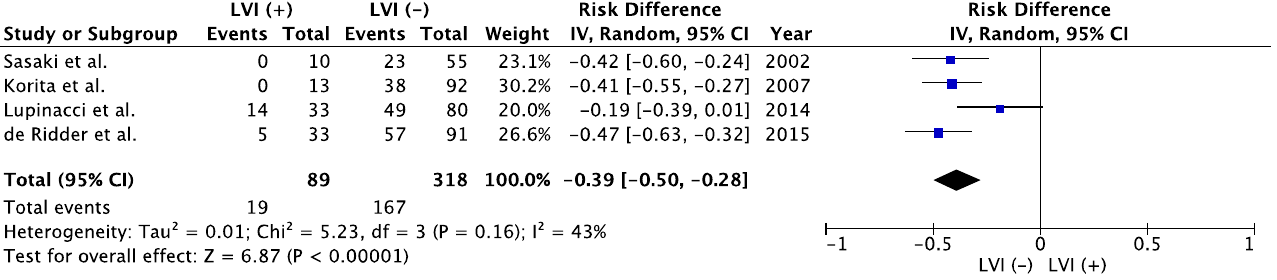
Figure 3. Meta-analysis of studies evaluating the impact of lymphatic vessel invasion on 5-year overall survival for colorectal liver metastasis. CI, confidence interval; IV, inverse variance; LVI, lymph vessel invasion [34–37].